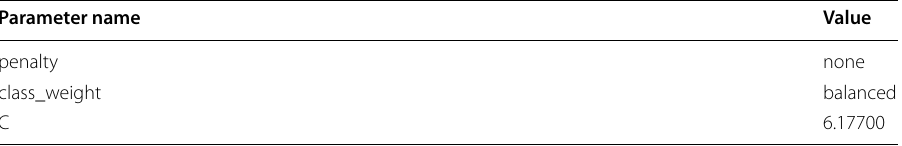
Table 80 Modes of LR tuned hyperparameter values for experiments with the data exfiltration